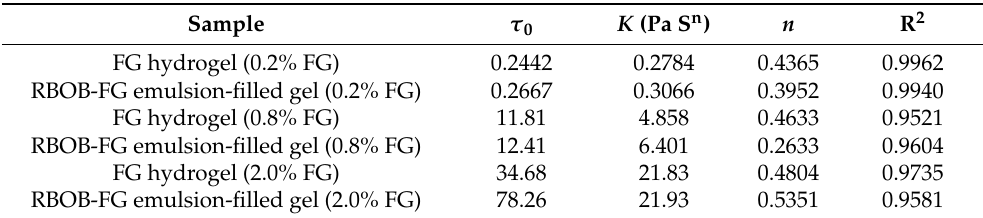
Table 1. Rheological parameters of the Herschel–Bulkley model for RBOB-FG emulsion-filled gels and FG hydrogel.